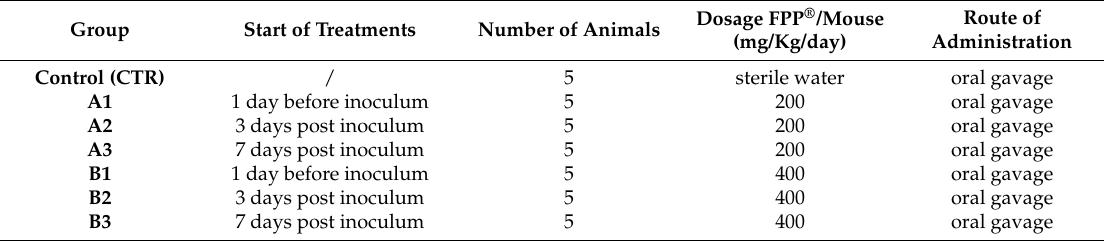
Table 1. Experimental scheme of second experiment in C57/Bl mice treated with FPP ® .